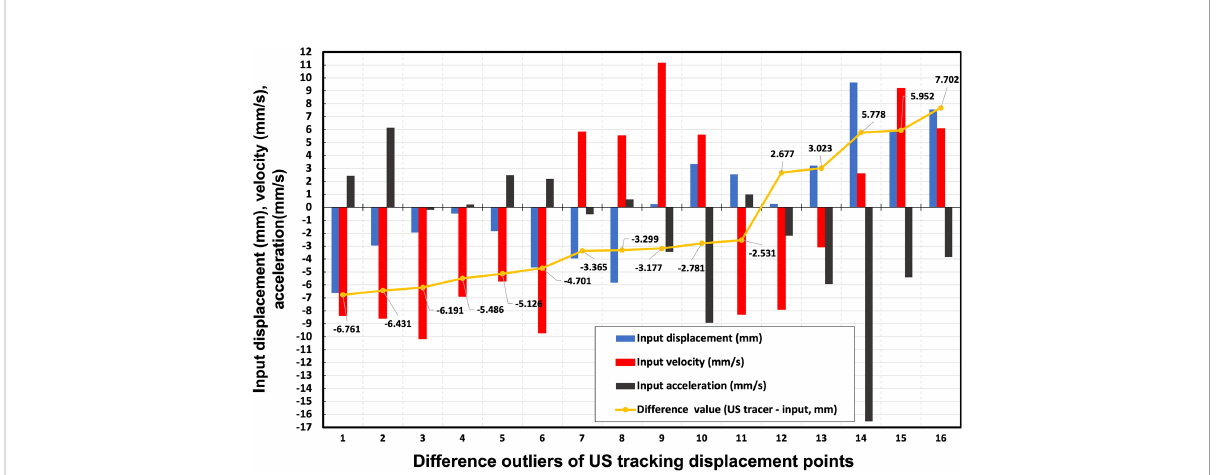
FIGURE 5 16 difference outliers of US tracking displacement points with the infrared monitoring value, infrared monitoring velocity, and infrared monitoring acceleration. The yellow points represent the difference between US tracking displacement and infrared monitoring values. The blue, red, and black bars are the input displacement, velocity, and acceleration of each tracking point,